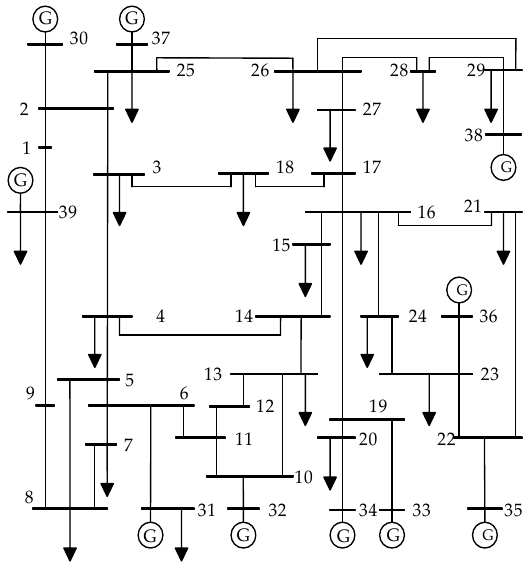
Figure 4. The IEEE New England 39-bus test system.